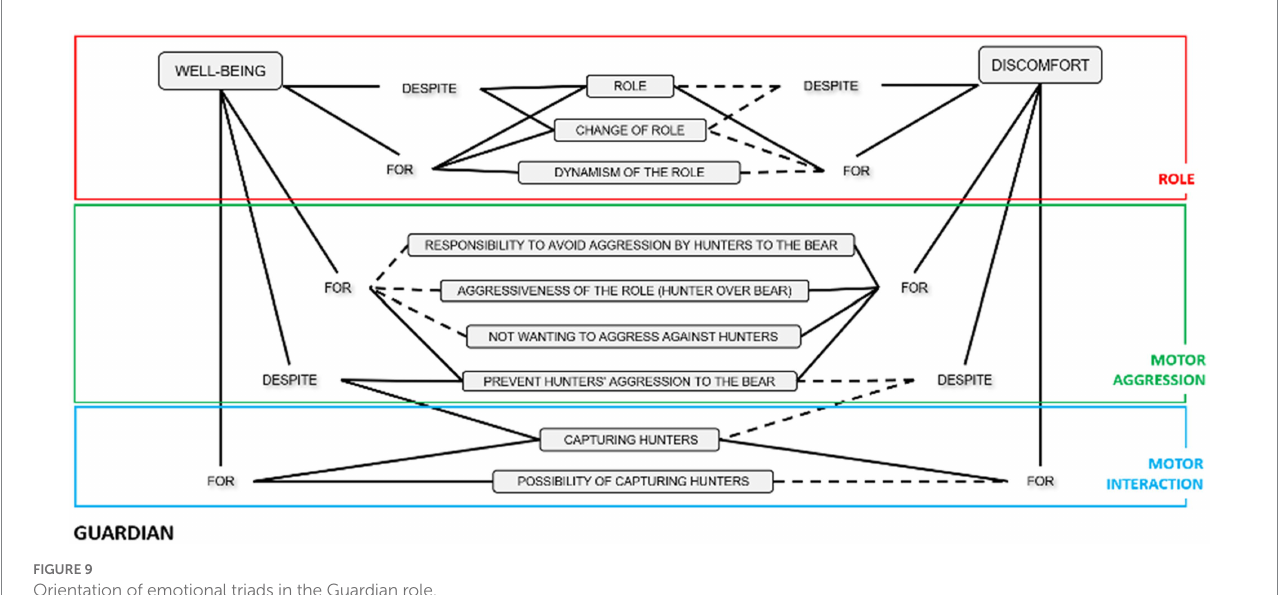
FIGURE 9 Orientation of emotional triads in the Guardian